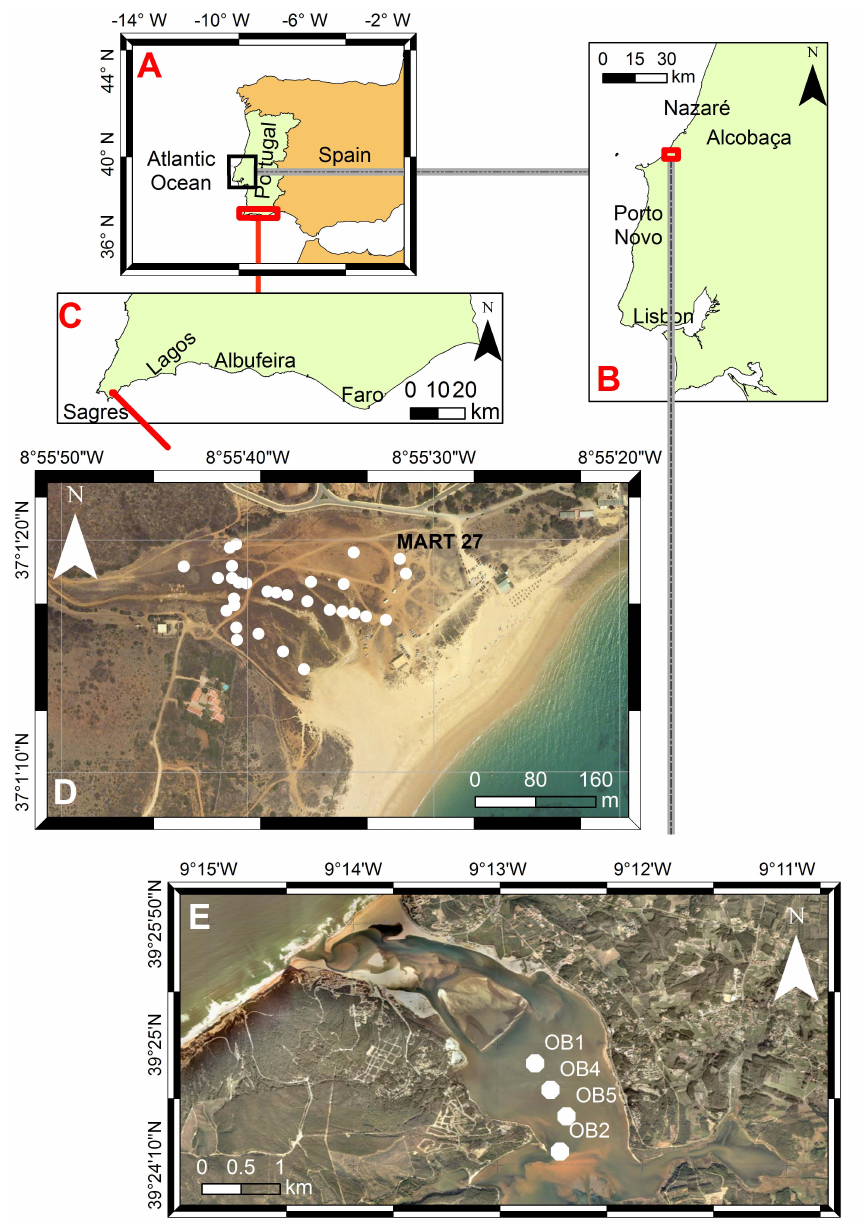
Fig. 1. Location map of Lagoa de ´Obidos and Martinhal. (a) general location map of the two study areas (Martinhal and Lagoa de ´Obidos). (b) regional location map of Lagoa de ´Obidos. (c) regional location map of Martinhal. (d) core location (27 March) in Martinhal. Other cores, previously studied (Kortekaas and Dawson, 2007) are also marked. (e) core locations within Lagoa de ´Obidos lagoonal